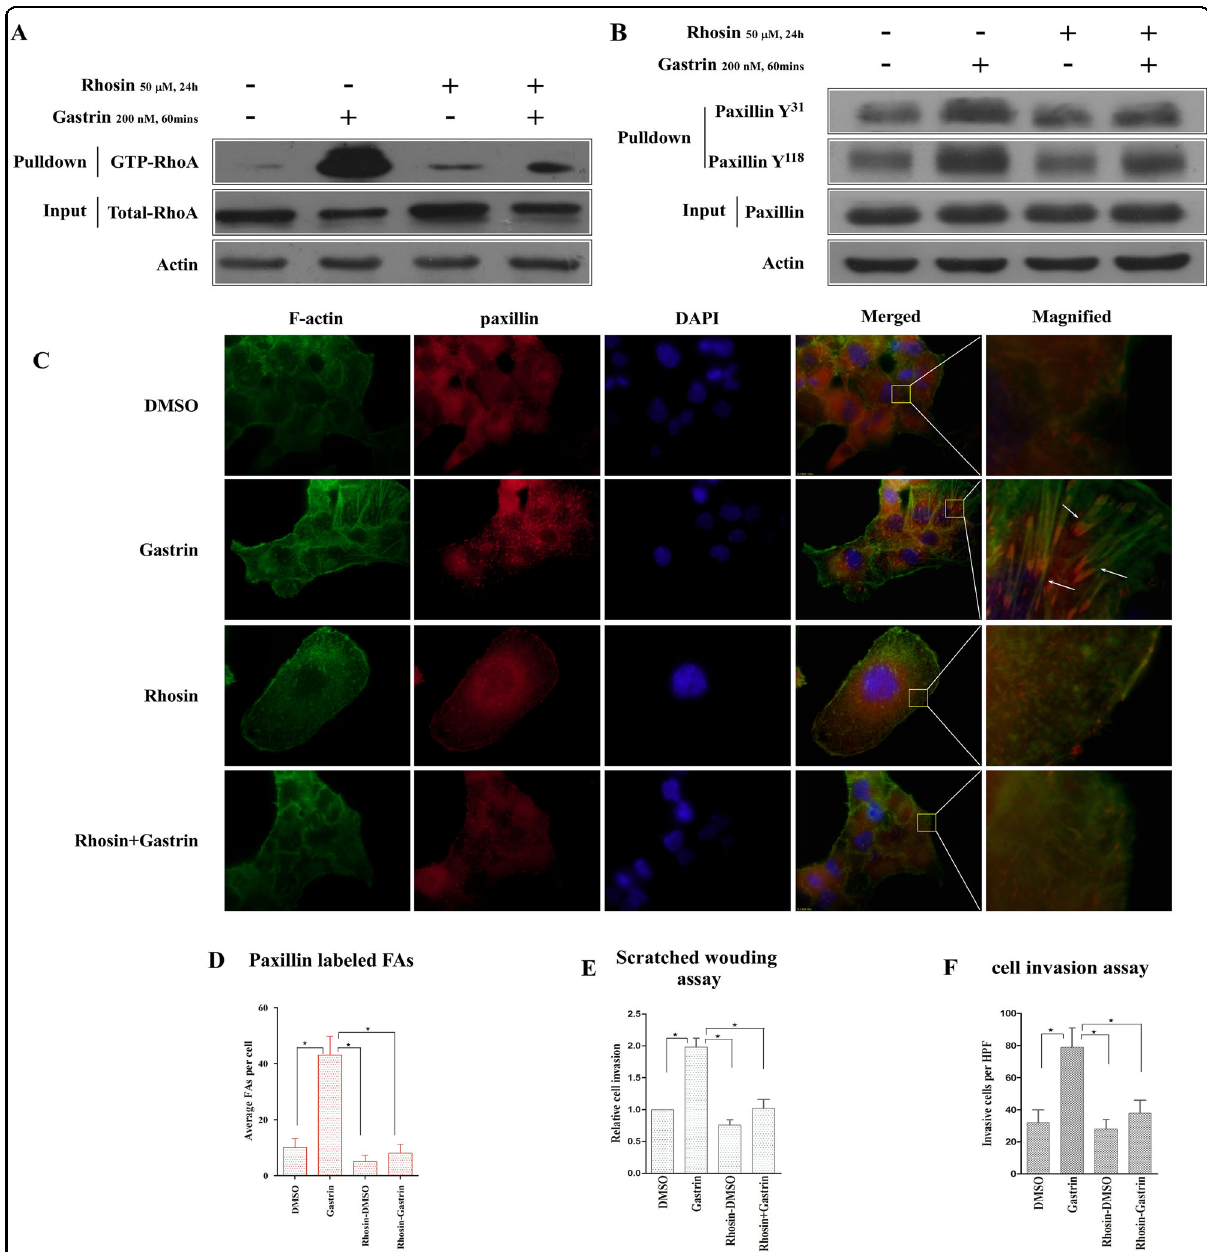
Fig. 3 RhoA is necessary for gastrin-stimulated paxillin tyrosine phosphorylation, cell polarization, and FA formation. PANC-1 cancer cells were pre-treated with Rhosin, an effective inhibitor of RhoA, for 24 h and were then incubated with gastrin for 1 h. a The gastrin-stimulated and endogenous activation of RhoA was signi fi cantly inhibited by Rhosin. b Rhosin pre-treatment suppressed the tyrosine phosphorylation of paxillin that was activated by gastrin. c The images indicate increased paxillin-labeled focal adhesion formation and aggregation at the cell leading-edge stimulated by gastrin, and Rhosin pre-treatment inhibited these changes. Boxed regions indicate the area of the merged image used for the zoom. White arrows show the focal adhesion formation and aggregation at the leading edge of cells. d The histogram indicates the mean number of focal adhesions labeled by paxillin per cell. The average number of focal adhesions from a minimum of 20 cells was calculated. e , f The scratched wound healing assay ( e ) and Boyden invasion assay ( f ) were performed to show the migration and invasion of PANC-1 cells. Values are represented as the means ± SD from three independent experiments. * P <